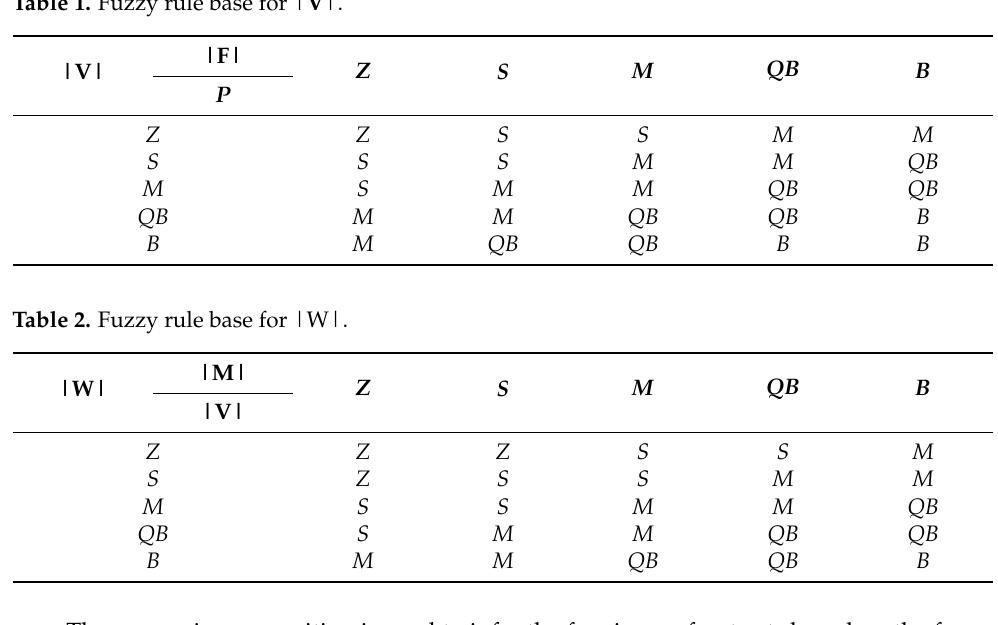
Table 1. Fuzzy rule base for | V |.